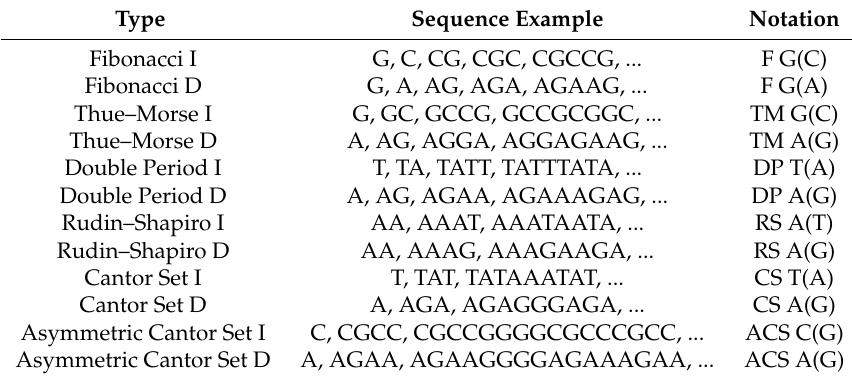
Table 1. Examples of the types of polymers studied in this work. I (D) denotes polymers made of identical (different) monomers. We only mention the 5 (cid:48) -3 (cid:48) base sequence along one of the two strands. X(Y) means that the zeroth generation (the “seed”) of the binary sequence contains solely X and the other letter in the sequence is Y. Type Sequence Example